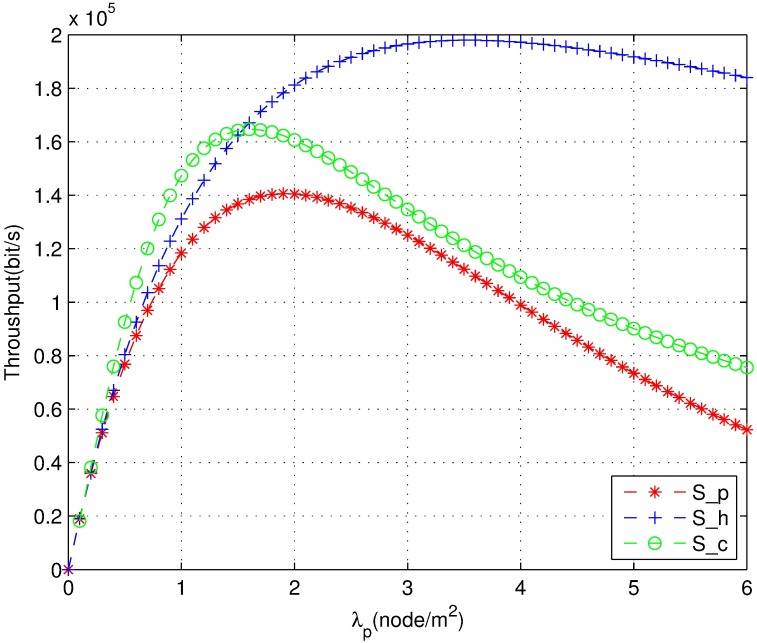
The throughput comparison of three mechanisms.